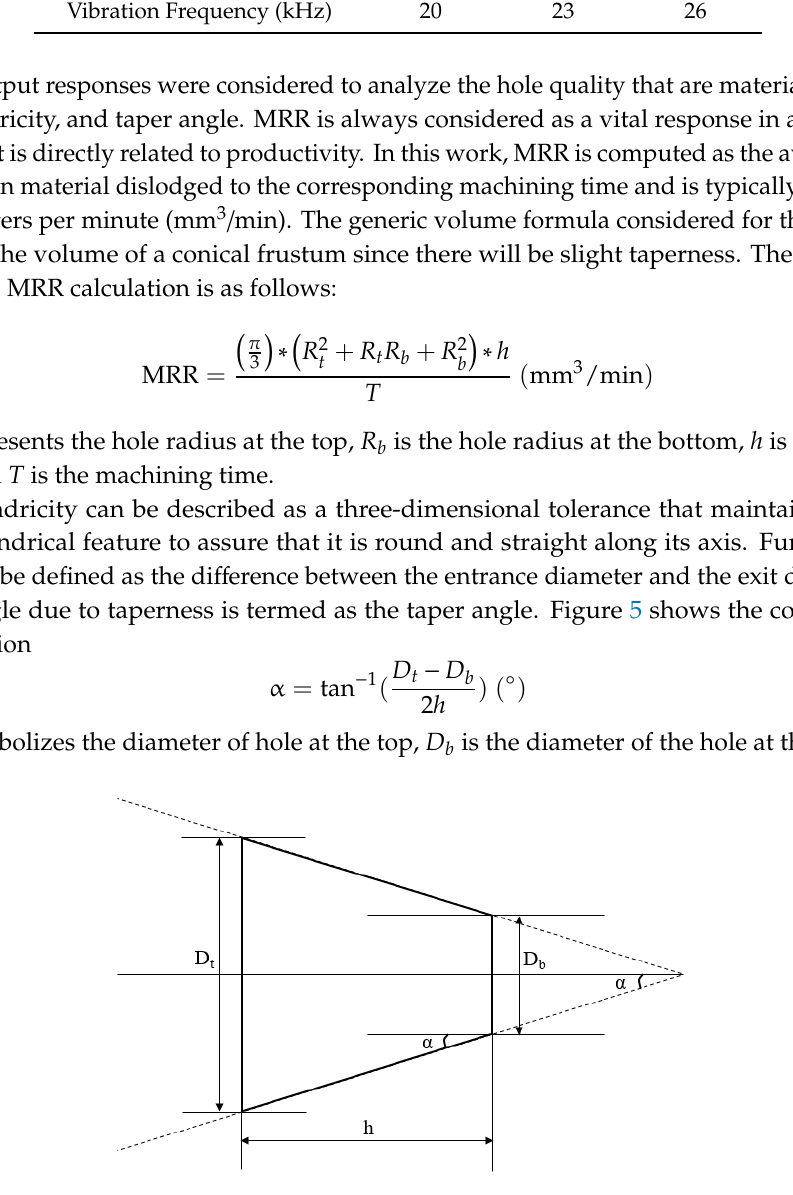
Figure 5. Taper angle calculation.